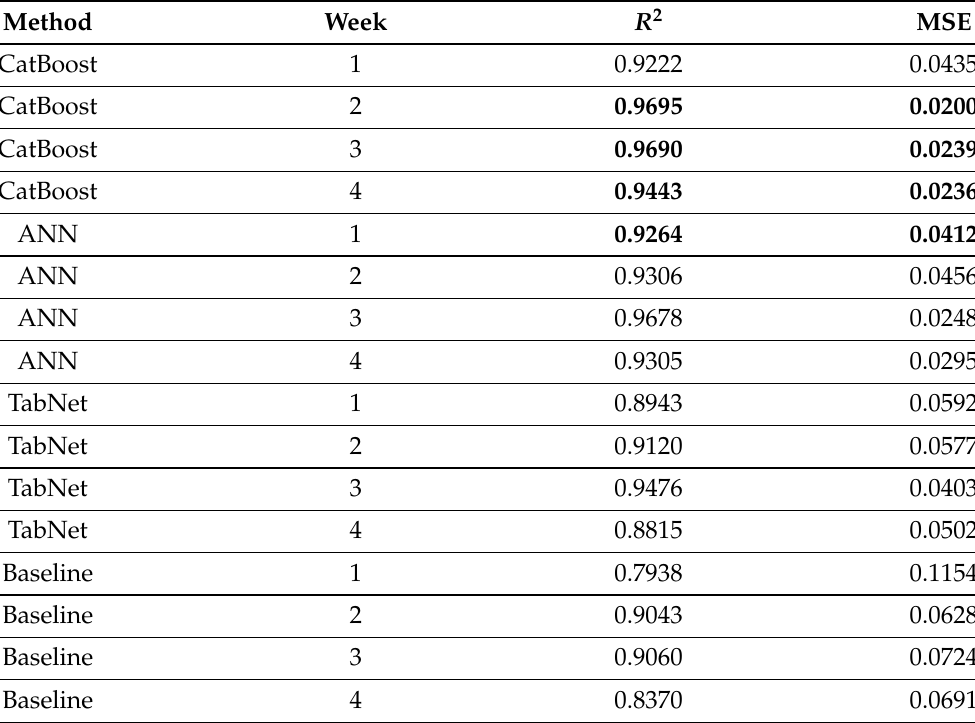
Table 3. Comparison of the three models for demand prediction in the four weeks. The highest R 2 and lowest MSE for each week are highlighted in